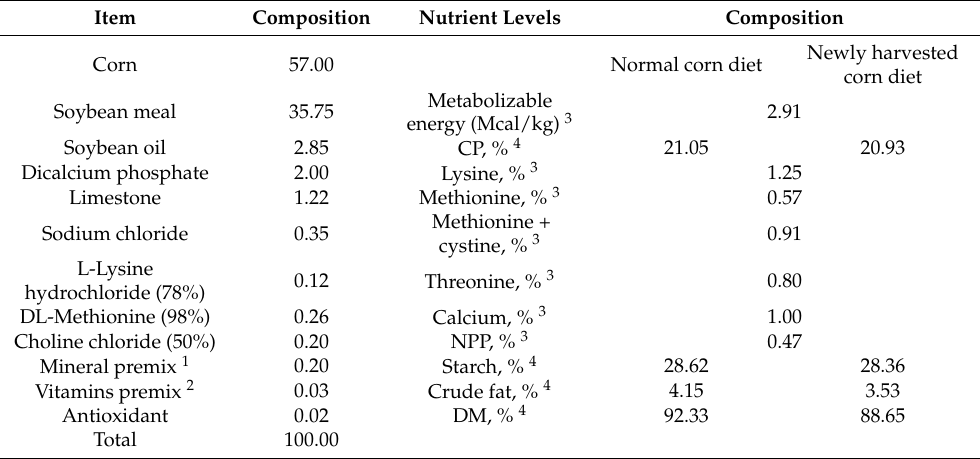
Table 3. Ingredient and nutrient composition of experimental diet (%, as-fed